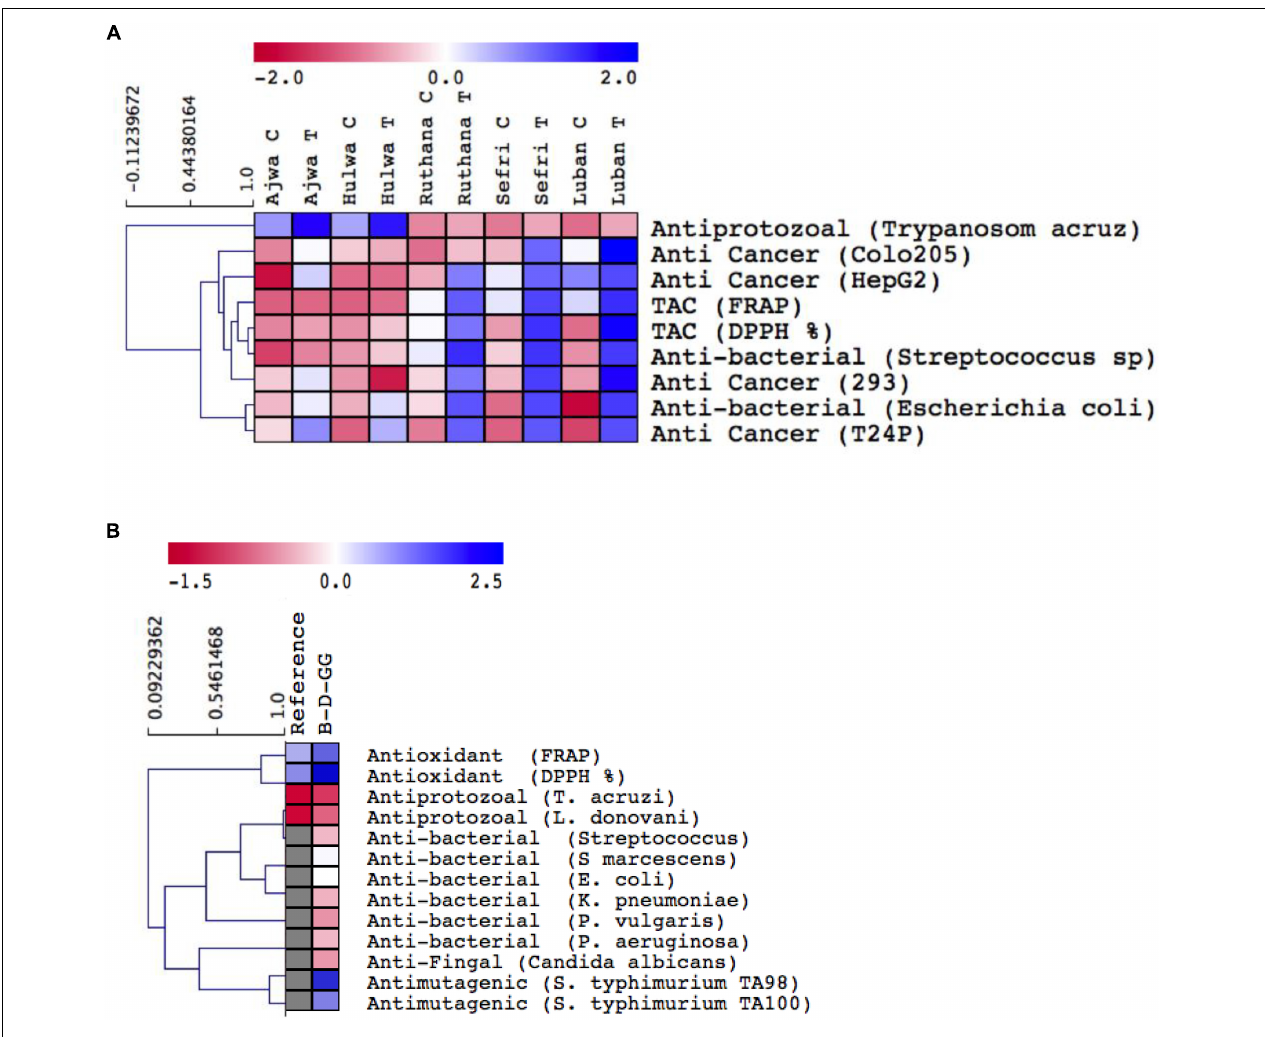
FIGURE 3 | Hierarchical clustering medicinal bioactivities of the ethanol extracts (A) of vermicompost-fertilized and non-fertilized P. dactylifera cv. Ajwa, Hulwa, Ruthana, Sefri, and Luban fruits and β - D -glucogallin (B) . Vermicompost fertilization was carried out at a rate of 10 Kg/tree and fruits were harvested at the tamar